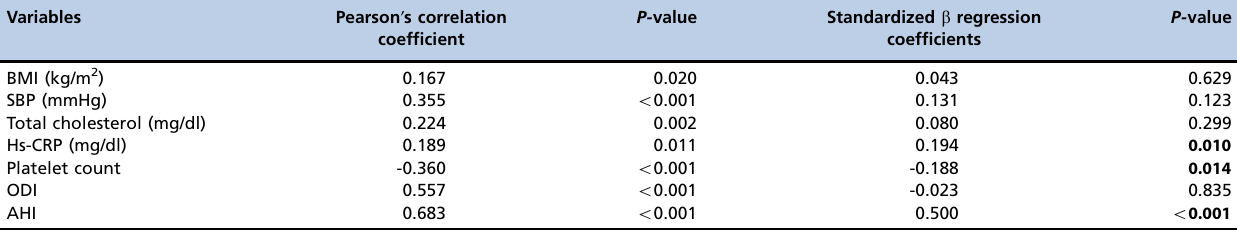
Table 2 - Bivariate and multivariate relationships of the MPV in patients with obstructive sleep apnea syndrome. P- Variables Pearson ’ s correlation coefficient